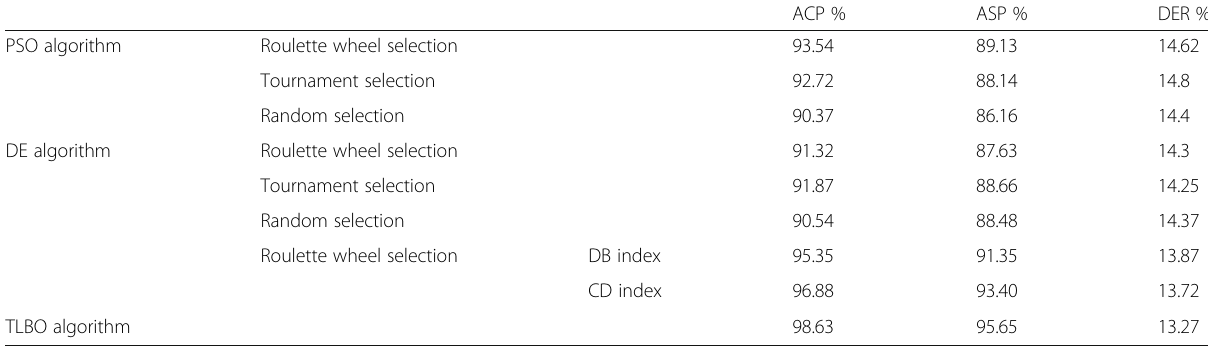
Table 7 ASP, ACP, and DER results obtained using PSO and DE algorithms with different selection modes and with different clustering validity indexes (DB and CS indexes). Also, ASP, ACP, and DER results are obtained using TLBO algorithm